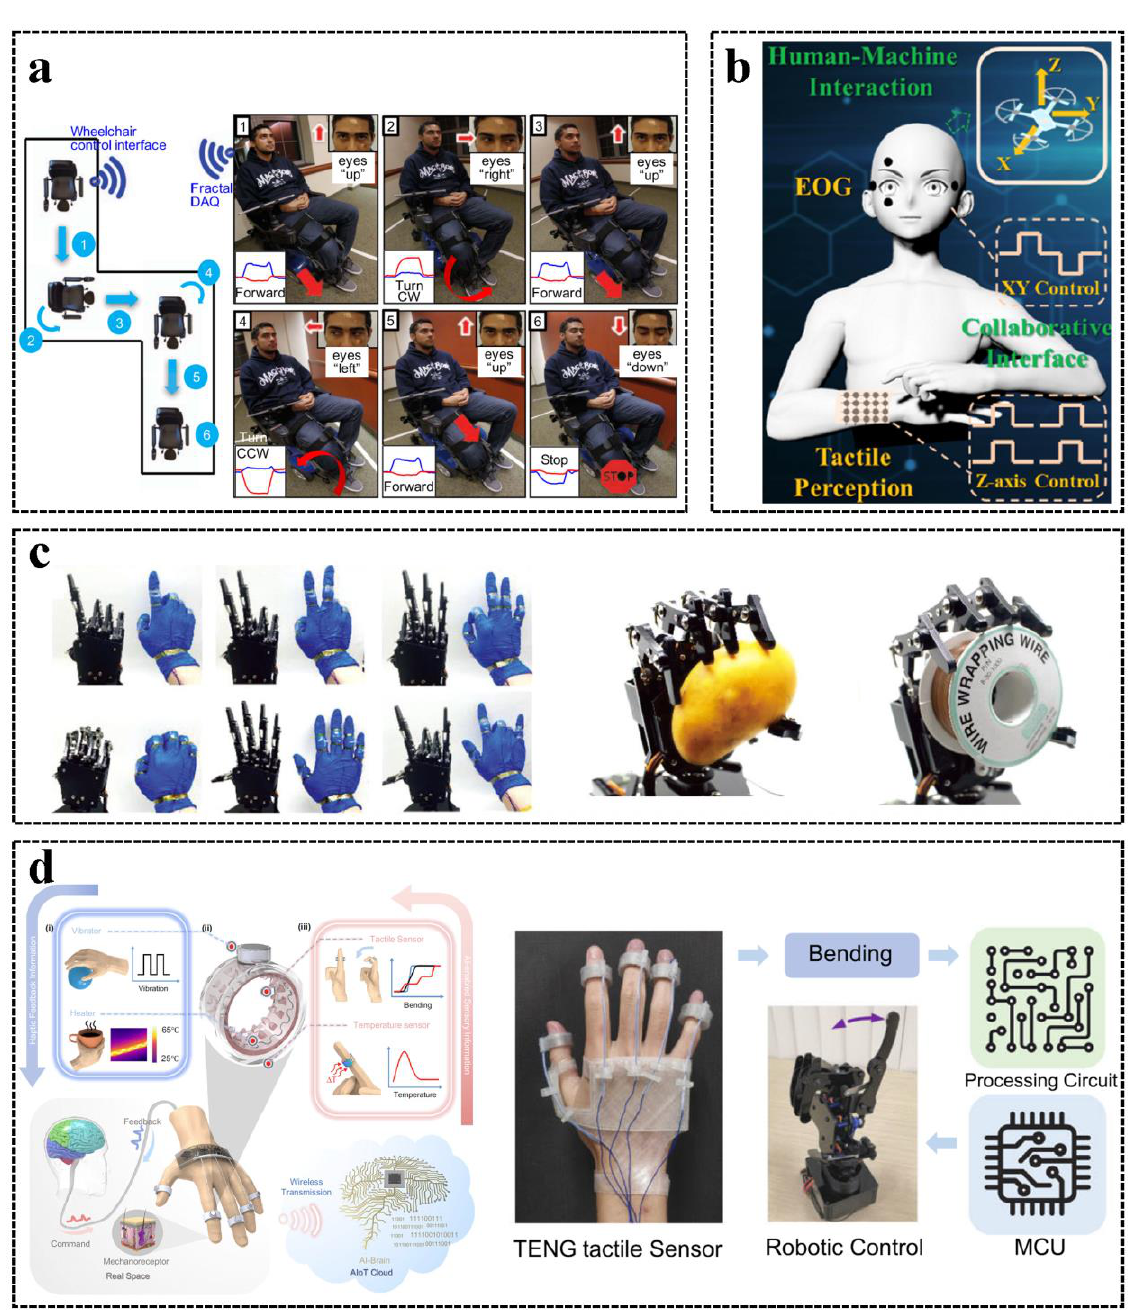
Figure 6. Multi-channel HMIs: ( a ) An HMI for wheelchair motion control via EOG signals. Repro- duced with permission [131], Copyright 2017, Elsevier B.V. ( b ) An EOG and tactile collaborative HMI for 3D control. Reproduced with permission [43], Copyright 2022, American Chemical Society. ( c ) A wearable HMI for robot hand control. Reproduced with permission [80], Copyright 2022,